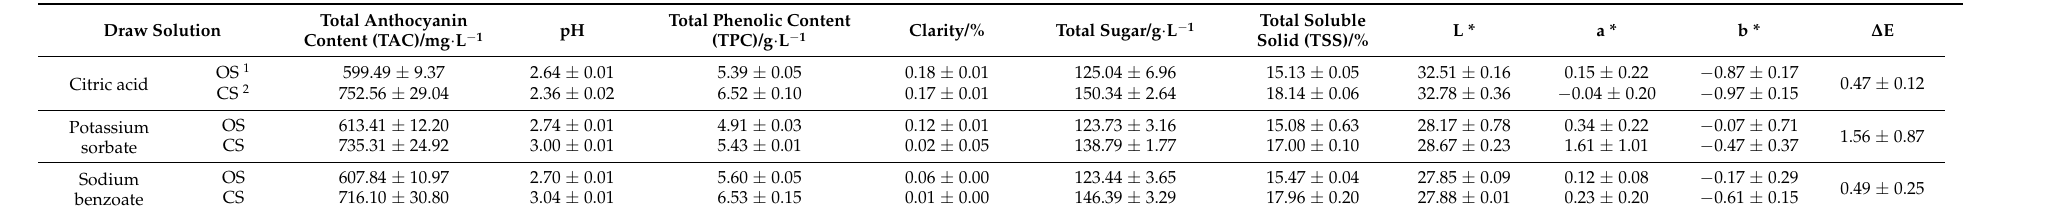
Table 1. Physicochemical properties of juices concentrated with three draw